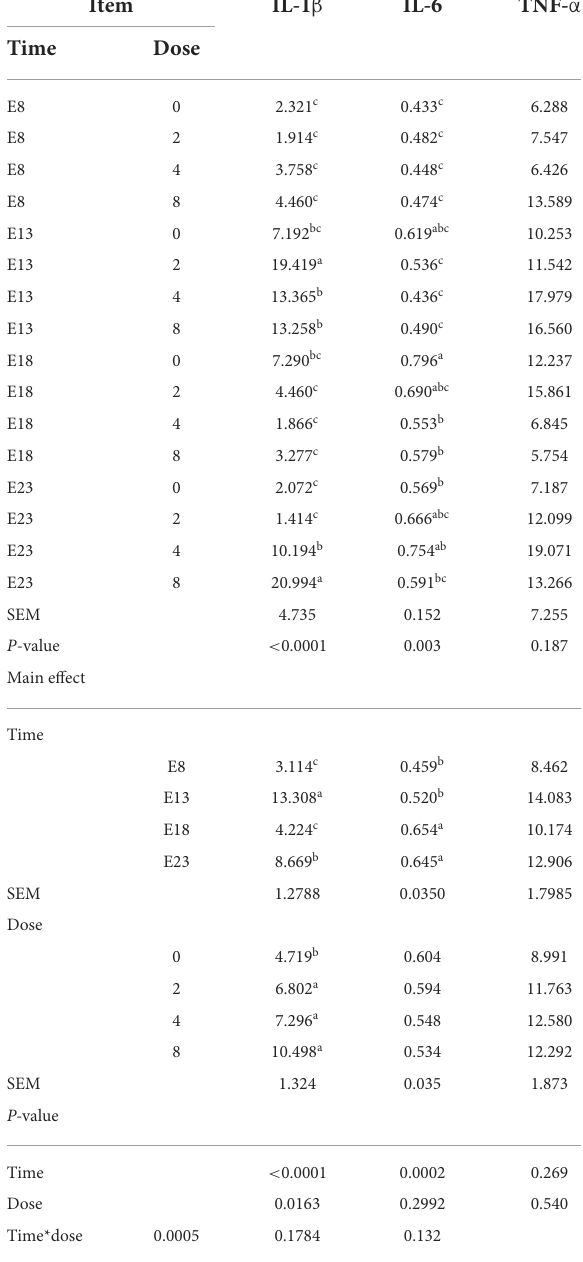
TABLE 6 Effect of time and doses of an embryo injected OTA on the jejunal inflammation cytokines of ducks at hatching 1